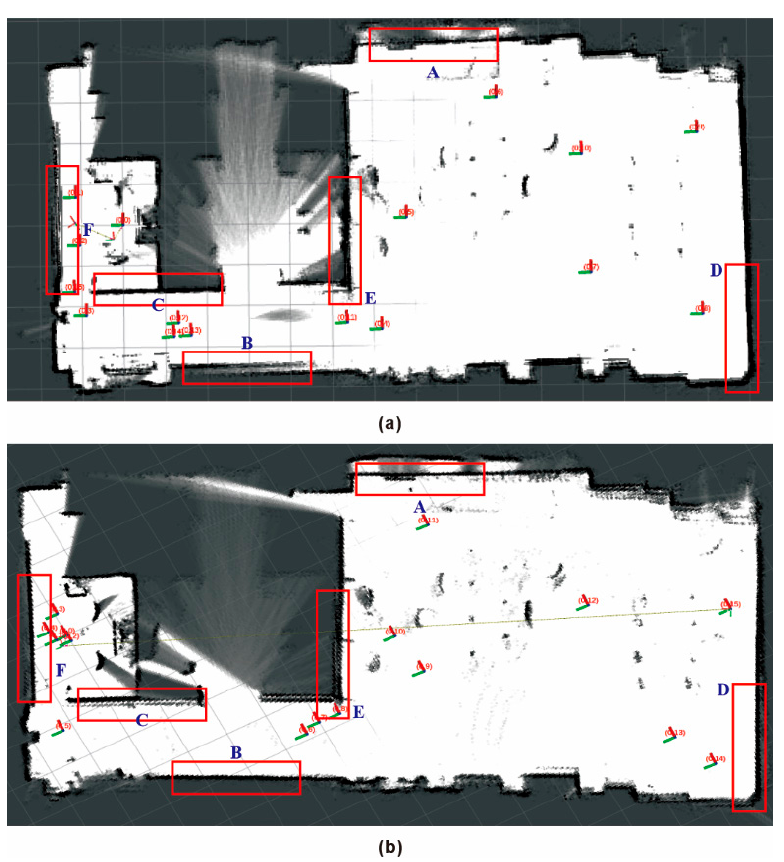
Figure 12. Comparison of mapping effects, and A–F are six selected comparison sub-regions. ( a ) The map was constructed by Cartographer algorithm. ( b ) The map was constructed by APF algorithm.